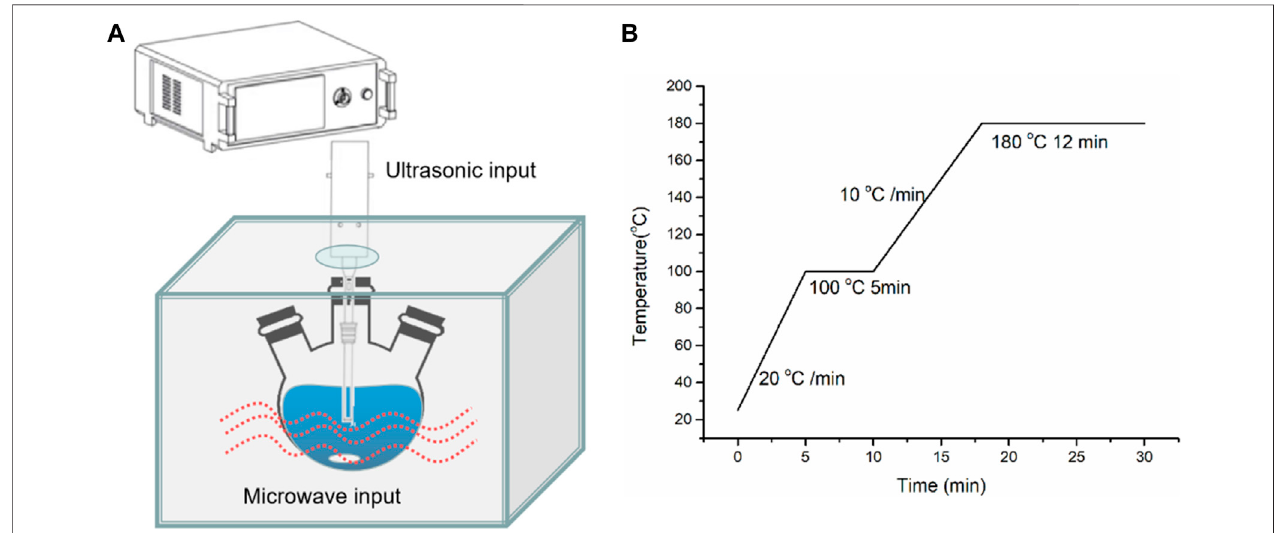
FIGURE 1 | Sketch of combined microwave – ultrasonic synthesis (A) and heating program (B) .